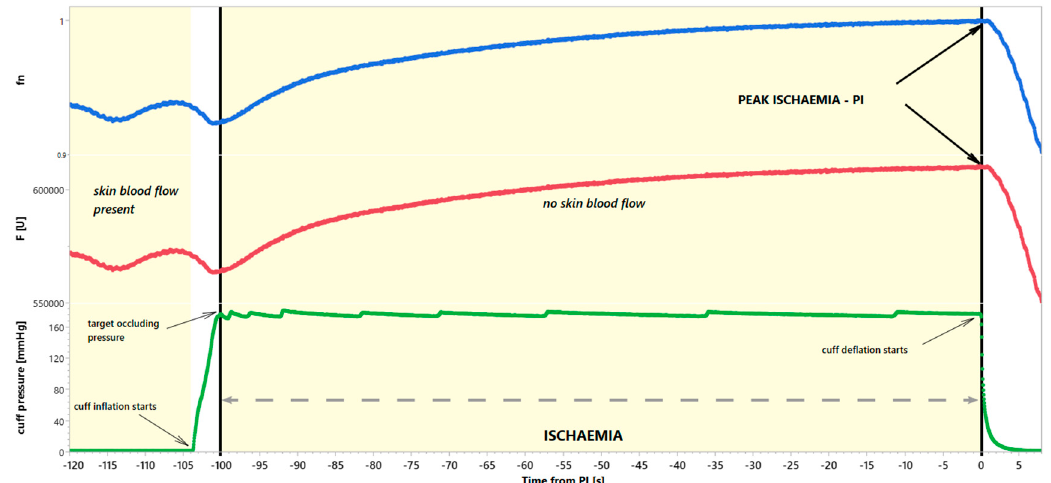
Figure 1. Example of NADH fluorescence plot after normalization to peak ischaemia (blue) and the corresponding fragment of the NADH florescence before normalisation (red) with visualisation of pressure changes in the cuff occluding the brachial artery (green). Fn—fluorescence after normalisation to PI, F[u]—fluorescence in absolute units.